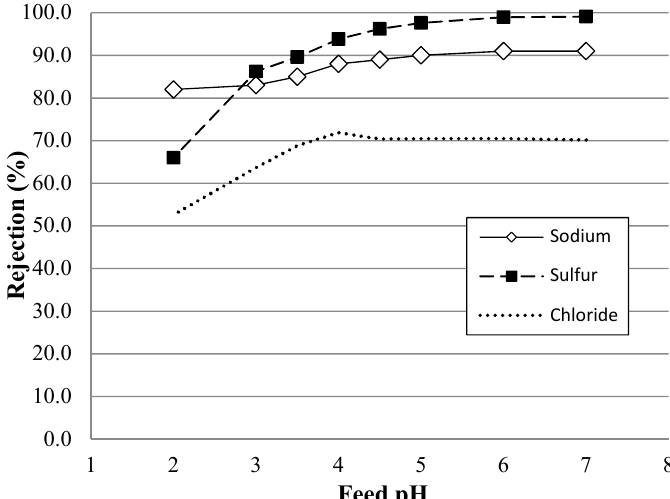
Figure 4. Apparent sulfur rejection (dashed line) sodium rejection (full line) and chloride rejection (dotted line) as a function of pH for Na 2 SO 4 and NaCl mixed salt solution. Experimental conditions: feed pressure = 10 bar, T = 25 °C. Concentrations of Na 2 SO 4 and NaCl = 2000 mg/L and 700 mg/L, respectively.